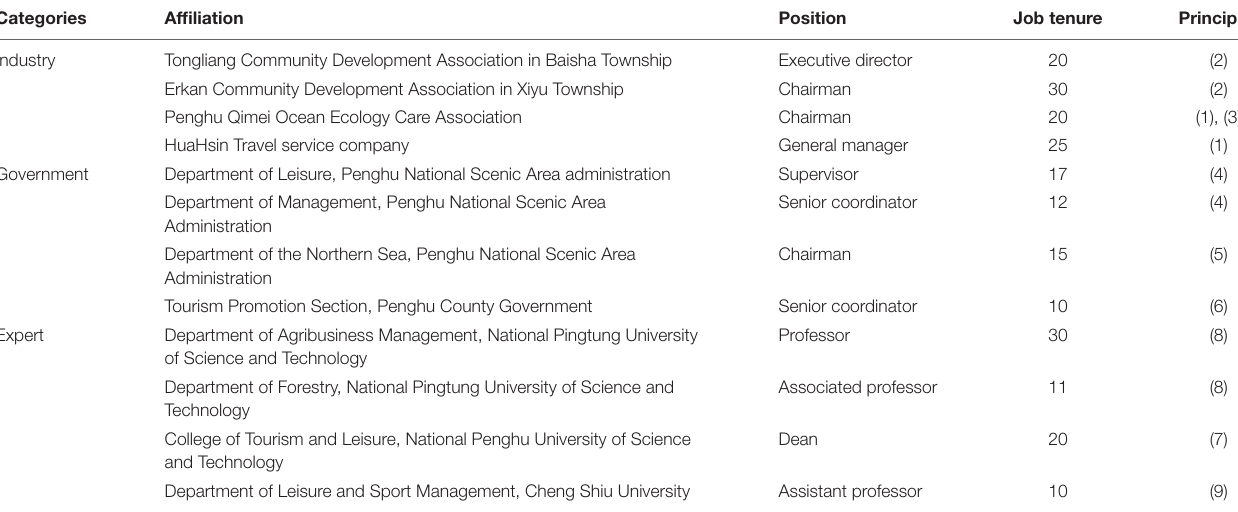
TABLE A1 | Fuzzy Delphi method members’ background for the first round.